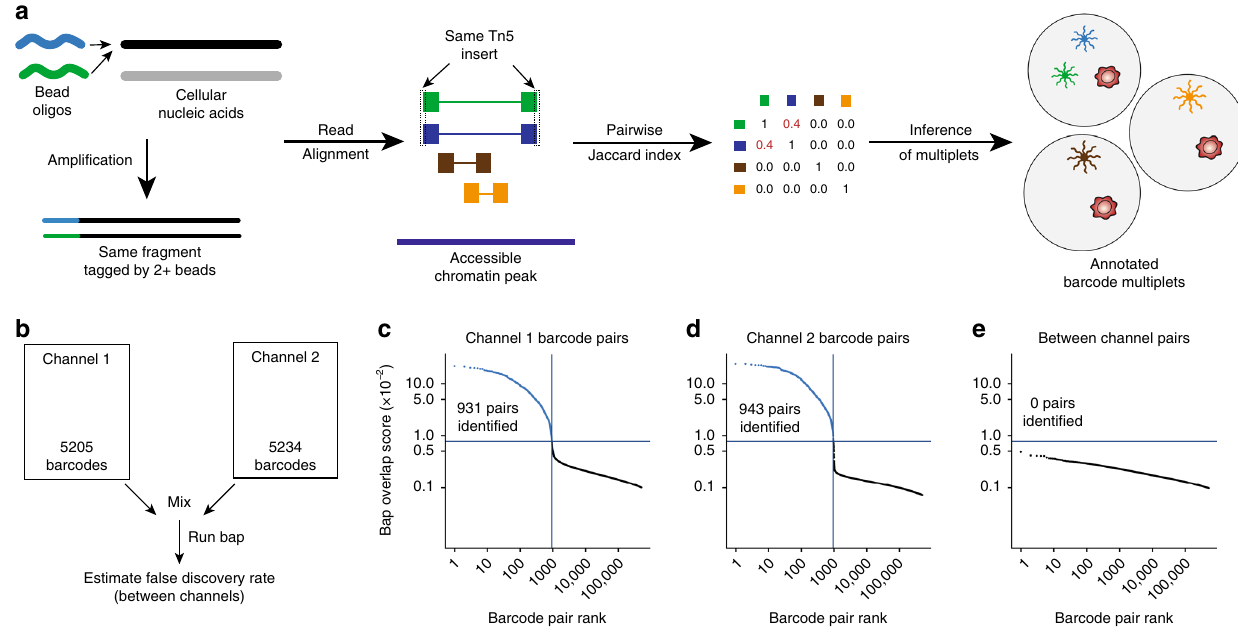
Fig. 2 Veri fi cation of bap to identify barcode multiplets using 10× scATAC-seq data. a Schematics of methodology to detect barcode multiplets whereby cellular nucleic acids are tagged by two different oligonucleotide sequences and later inferred from sequencing a scATAC-seq library from the same Tn5 insertions per fragment. b Schematic of mixing experiment. Two channels were combined and the resulting merged fi les were analyzed with bap. c – e Knee plots comparing the top 500,000 barcode pairs from c only channel 1, d only channel 2, and e between channels. The number of pairs calls is indicated by the number of points above the blue horizontal line (see Methods